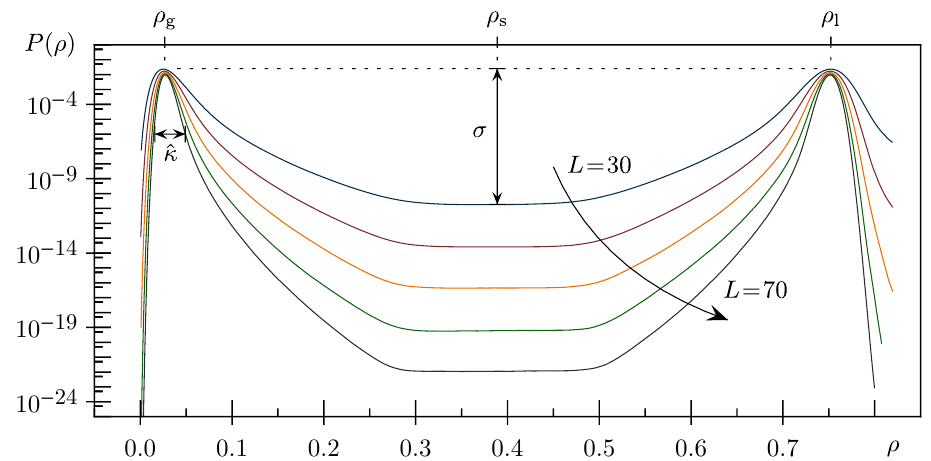
Figure 4: Grand canonical probability distribution of density at increasing linear sys- tem size L = 30,40,...,70 and T = 0.4 at equal-height chemical potential. Peak posi- tions in terms of density stay almost the same, while the systematic decrease in peak width – and seemingly in ˆ κ – is accounted by the relation between density and par- ticle number; the amount of possible N -values for a given density interval increases with system size so that the compressibility stays constant after all. The depth of the probability suppression at ρ is a measure for the linear interface tension σ . It stems s from the single liquid strip spanning across the system through periodic boundary conditions, as depicted in Fig.